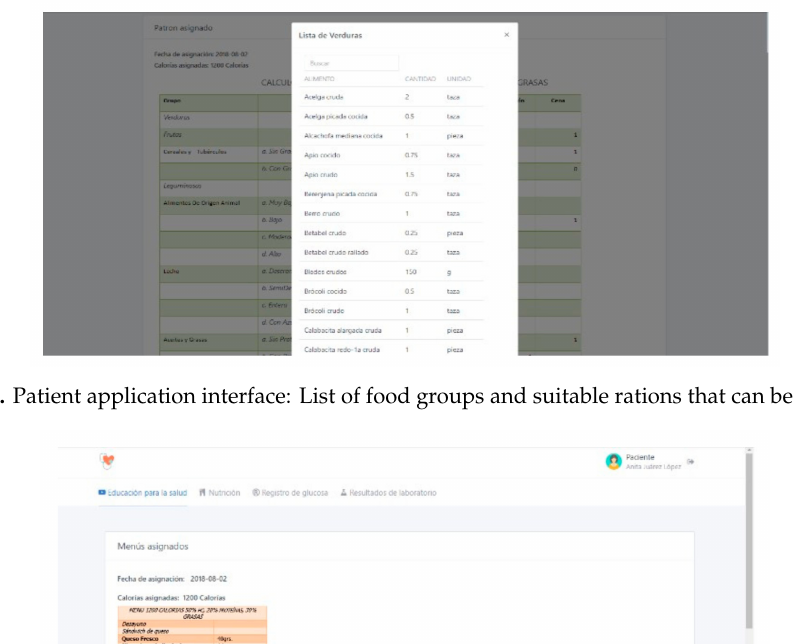
Figure 40. Patient application interface: Consultation of the assigned eating pattern.